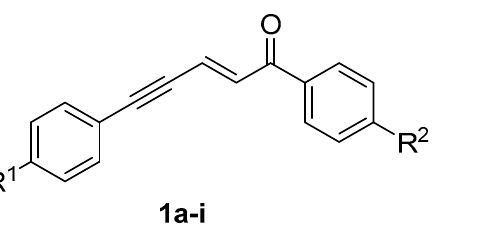
Figure 1. Starting 1,5-diarylpent-2-en-4-yn-1-ones used in this study.